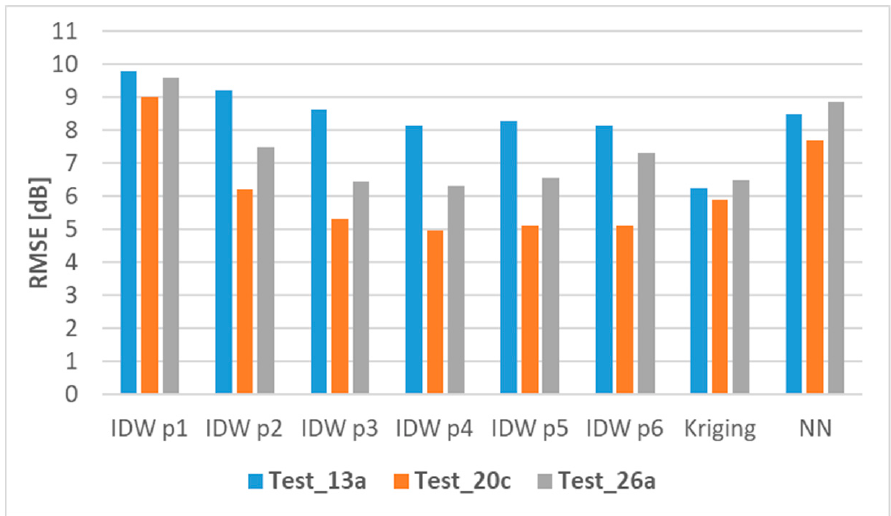
Figure 4. RMSE (value in dB) for tests with 13, 20, and 26 sensors—lowest RMSE test case.